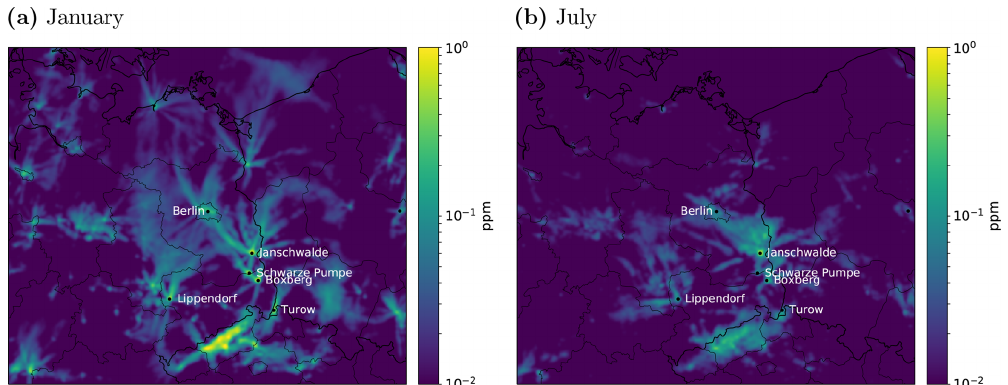
Figure 10. Difference in 11:30LT column-averaged dry air mole fractions (XCO 2 ) between tracers CO2_SURF and CO2_VERT in (a) Jan- uary and (b)